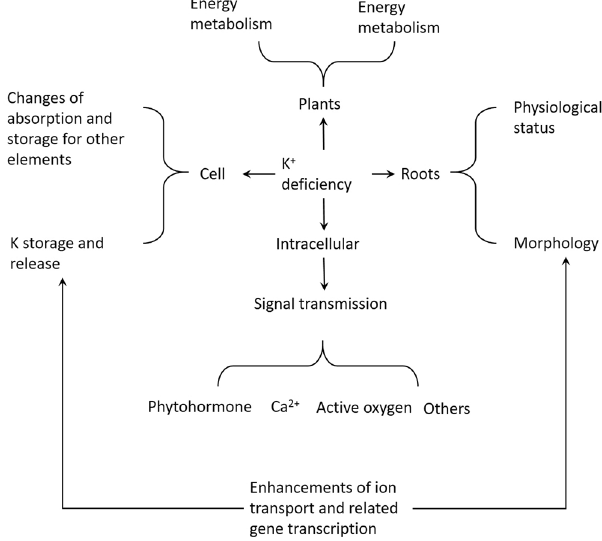
Figure 6. A hypothetical model of low K + stress tolerance mechanism underlying in rice root at seedling